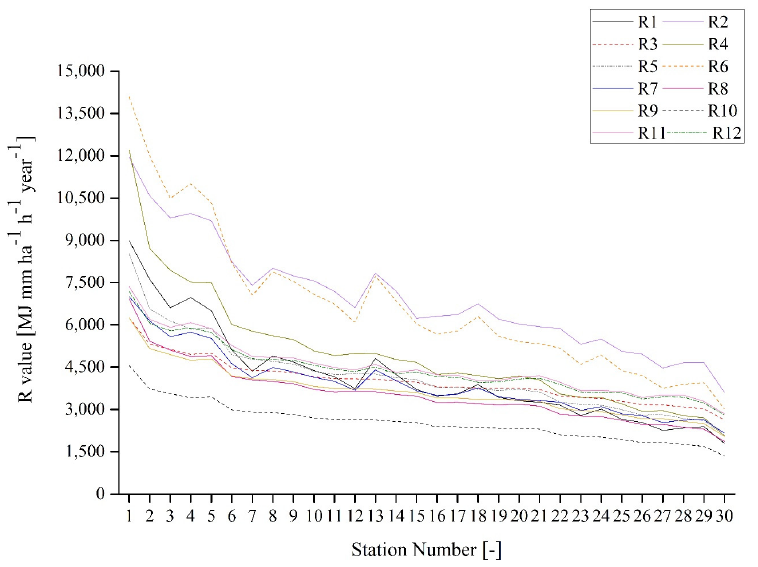
Figure 4. Average rainfall erosivity values obtained with the selected 12 formulas for each Rain gauge station. The stations were numbered in order of decreasing observed yearly cumulative rainfall value. Even if the average and minimum values are similar, we can observe strong rainfall differences between all the formulas in the maximum rainfall erosivity values. Here the difference of the values can vary from about 8000 MJ mm ha − 1 h − 1 year − 1 , that is the lowest maximum value (R10), to more than 24,000 MJ mm ha − 1 h − 1 year − 1 for R4 and R6 formulas. The rain gauge station that generated the maximum rainfall erosivity values is the Monte Terminillo station (Station number 18 in Figure 4), in the year 2010. In the year 2010, it is possible to see that 14 of the rain gauge stations produced their rainfall erosivity maximum values. The rainfall erosivity equations that generated the maximum values are R4 and R6, both coming from Renard and Freimund’s research [37] . The first one utilizes the annual mean precipitation, the second one the Modified Fournier Index (MFI), and both are exponential equations. It is interesting to note that R5, that comes from the same research, does not have such a high maximum rainfall erosivity value. Indeed, the maximum value for this equation is almost 15,000 MJ mm ha − 1 h − 1 year − 1 , while R4 and R6 present a 25000 MJ mm ha − 1 h − 1 year − 1 value. From the aforementioned analysis, it is not possible to individuate a reference equation to estimate the rainfall erosivity, probably because too few rainfall data are available. In fact, the sample of data at our disposal is not "hydrologically" significant. In order to overcome the scarce availability of rainfall data and to individuate a reference equation for rainfall erosivity, an additional analysis has been conducted, using 50 years of synthetic rainfall time series generated for Colle sul Velino rain gauge station (Station number 13 in Figure 4). The rain gauge station choice is based on the considerations seen in Figure 5, where it appears evident that Colli sul Velino station